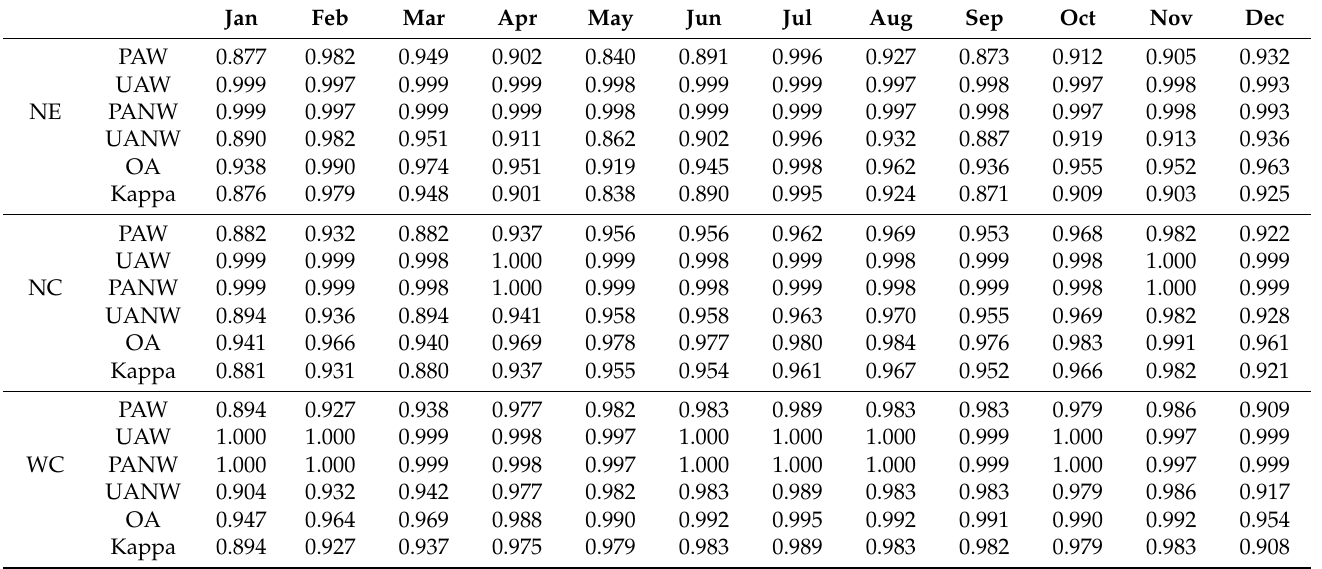
Table 1. Accuracy evaluation results between this study and JRC GSW data in each month of